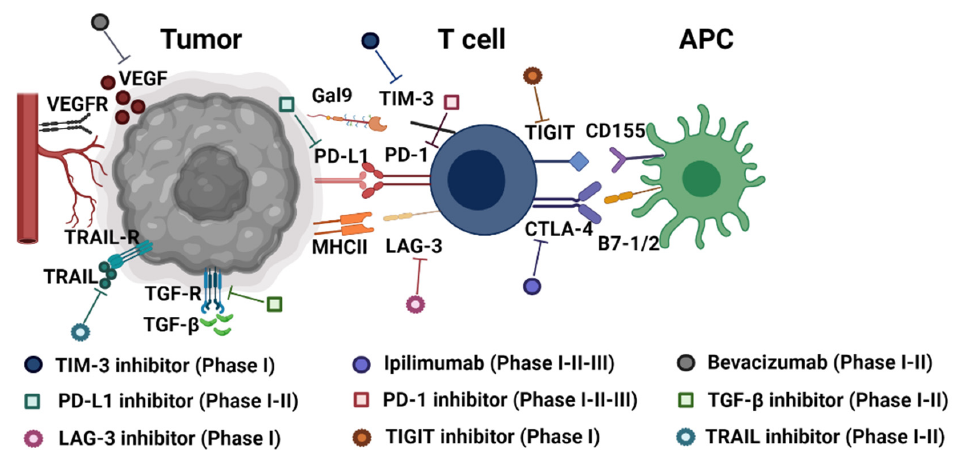
Figure 2. Targeting immune checkpoint molecules in malignant glioma. Immune pathways and actions of checkpoint inhibitors that are necessary to maintain antitumor activity. Immune checkpoint molecules are expressed on the surface of T cells and interact with their ligands on antigen-presenting cells (APCs; such as dendritic cells). The phase of clinical trials targeting each immune checkpoint molecule in glioma patients is indicated as I, II, or III. VEGFR: vascular endothelial growth factor receptor, VEGF: vascular endothelial growth factor, TRAIL-R: TNF-related apoptosis-inducing ligand receptor, TRAIL: TNF-related apoptosis-inducing ligand, TGF-R: transforming growth factor beta receptor, TGF- β : transforming growth factor beta, Gal-9: galectin 9, TIM-3: T-cell immunoglobulin and mucin-domain containing-3, PD-L1: programmed cell death ligand-1, PD-1: programmed cell death protein-1, MHCII: major histocompatibility complex II, LAG-3: lymphocyte-activation gene 3, CTLA-4: cytotoxic T-lymphocyte antigen 4, B7: co-stimulation ligand, TIGIT: T cell immunoreceptor with Ig and ITIM domains, CD155: cluster of differentiation 155. Figure created with Biorender.com (accessed on 2 July 2021).